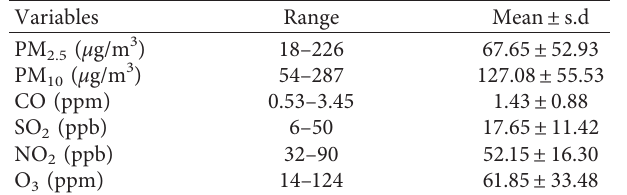
Table 1: Descriptive statistics results of air pollution data.